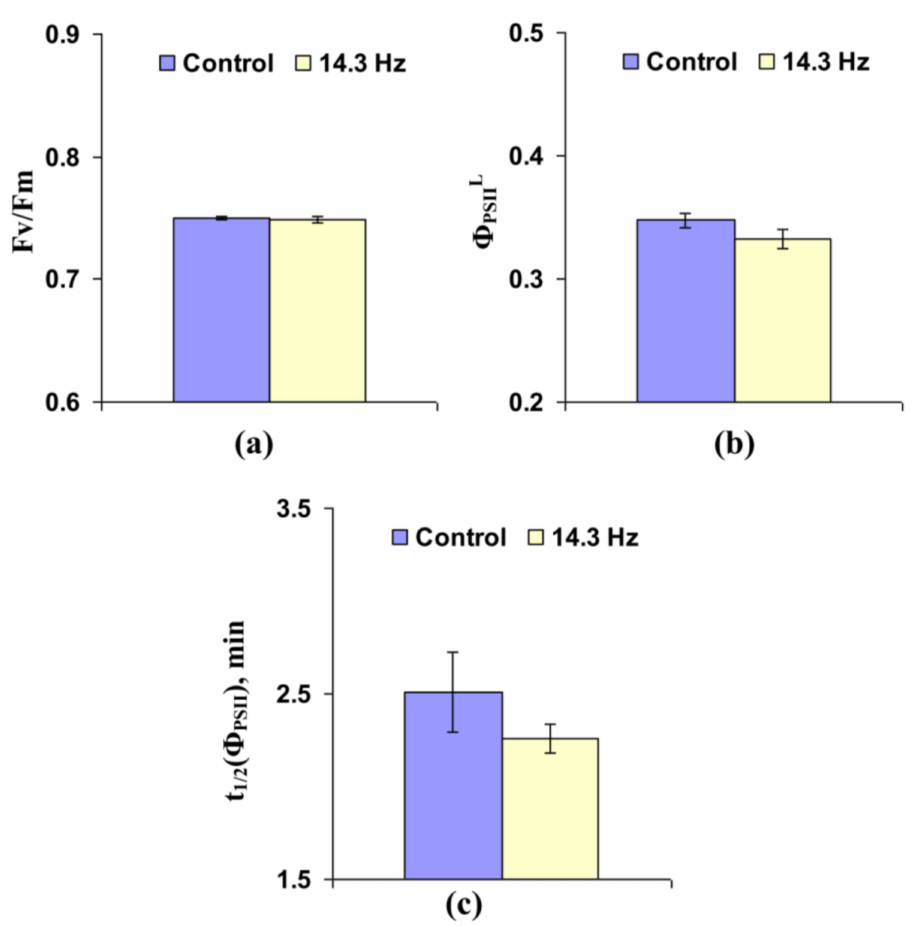
Figure 9. Influence of chronic treatment by the artificial extremely low frequency magnetic field on the potential quantum yield of photosystem II (Fv/Fm) ( a ), effective quantum yield of photosys- tem II under illumination ( Φ PSIIL ) ( b ), and time taken for 50% increase of Φ PSII under illumination (t 1/2 ( Φ PSII )) ( c ) in pea seedlings ( n = 6). Chronic action of the artificial magnetic field was initiated from soaking of seeds. Magnitude of the magnetic field was 18 µ T; frequency was 14.3 Hz. Pho- tosynthetic parameters were measured by the action of this field. Control plants were not treated by this artificial magnetic field. Significant differences between the experiment and control plants were